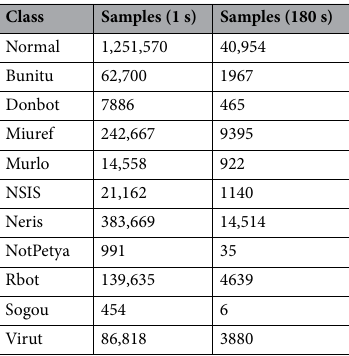
Table 2. Samples extracted per traffic class in the used dataset when the traffic is divided in time windows of one second or 180 s.